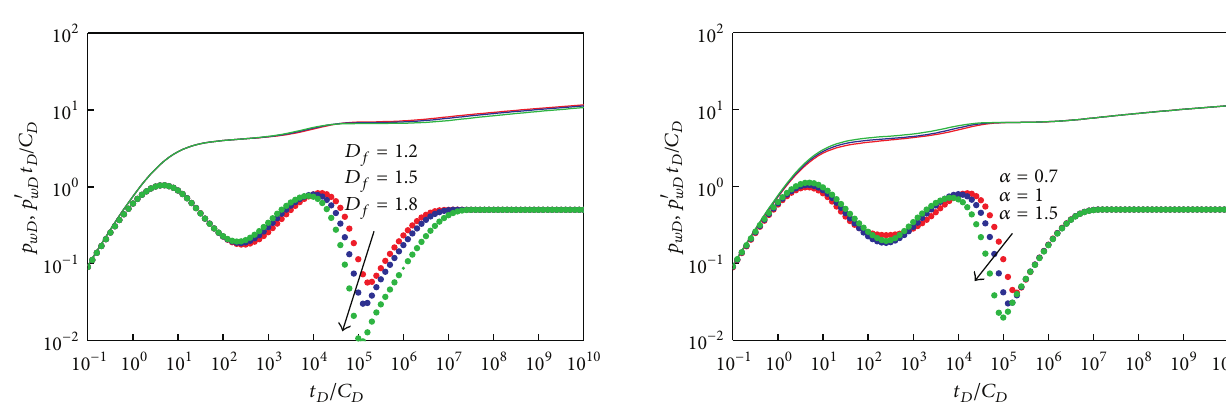
= 0.0001 , ℎ = 10 m, 𝐶 𝐷𝑒